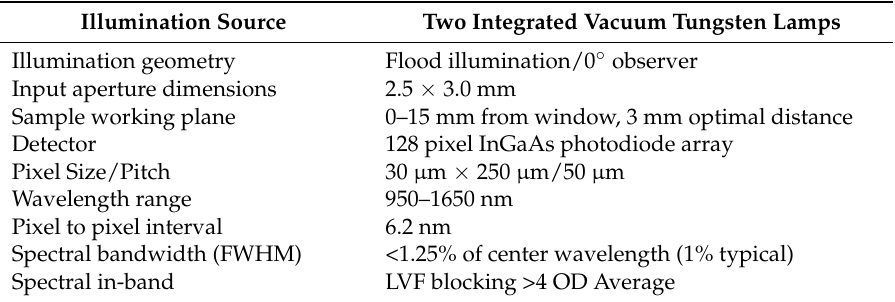
Table 3. Micro near-infrared (MicroNIR) instruments’